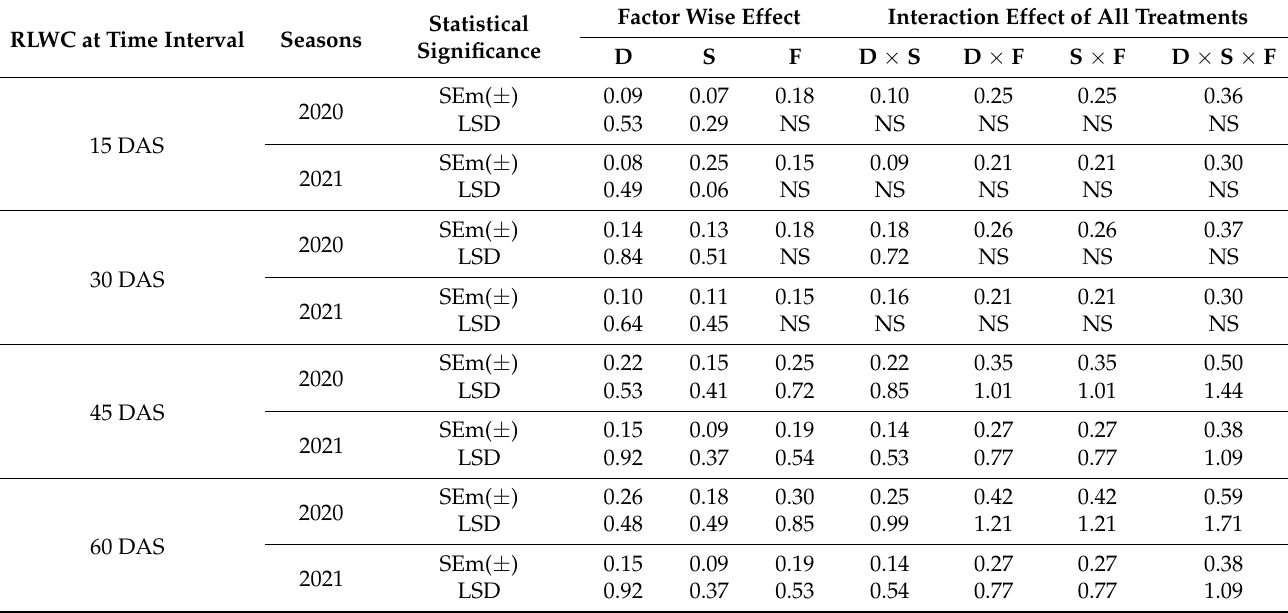
Table 8. Statistical significance and interaction effects of date of sowing, soil application of Co and foliar spray of K and B on the relative leaf water content of black gram during the spring–summer season. RLWC at Time